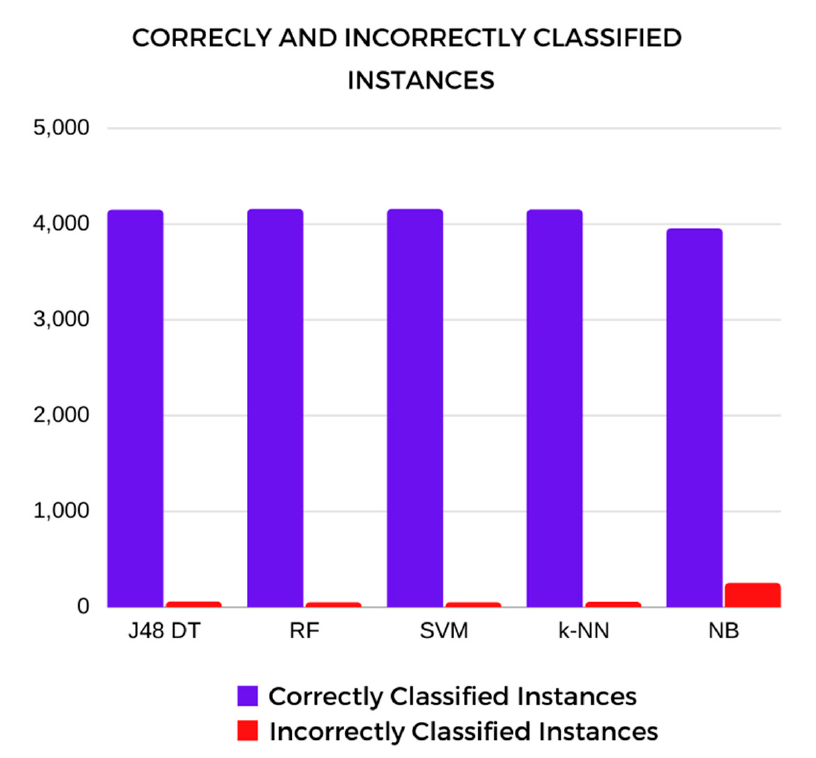
Figure 9. The bargraph that shows the number of correctly classified instances of the developed models. The blue bar represents the correctly classified instances and the red bar is the misclassified instances.